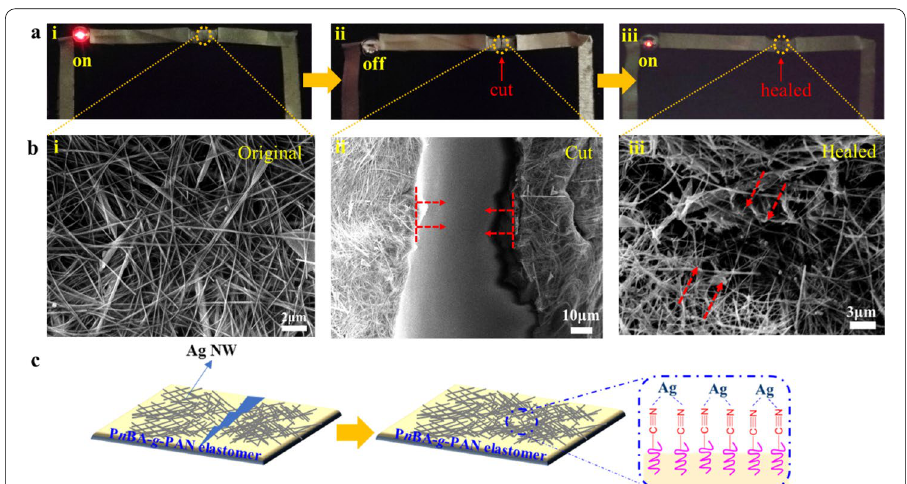
Fig. 4 a Photographs of an LED integrated with Ag nanowires/P n BA- g -PAN elastomer for self-healing tests. b SEM images of Ag nanowire/P n BA- g -PAN composite elastomer conductor: (i) original one, (ii) after being cut, and (iii) after healing. c The healing mechanism of composite elastomer by dynamic